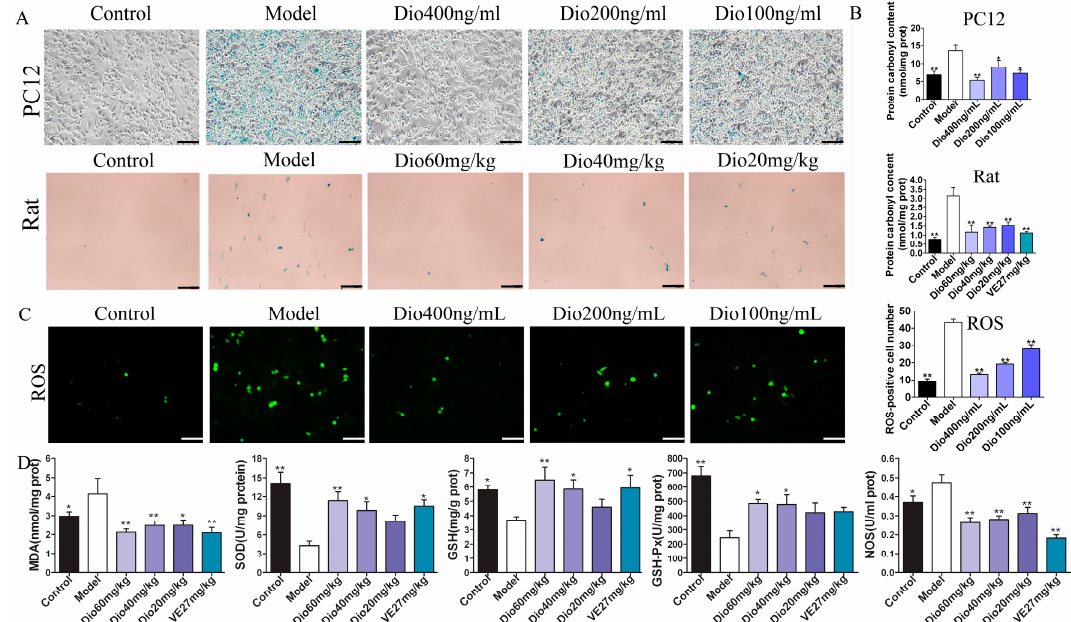
Figure 6. Effects of dioscin on oxidative damage and cell senescence in vitro and in vivo. ( A ) Dioscin reduces cell senescence in vitro (200× magnification, Scale bar = 100 μ m) and in vivo (400× magnification; Scale bar = 50 μ m). ( B ) Dioscin reduces protein carbonyl content in vitro and in vivo. ( C ) Effects of dioscin on intracellular ROS level in PC12 cells treated by H 2 O 2 (200× magnification; Scale bar = 100 μ m). ( D ) Effects of dioscin on the levels of malondialdehyde (MDA), superoxide dismutase (SOD), glutathione (GSH), glutathione peroxidase (GSH-Px) and nitric oxide synthase (NOS) in brain tissue of aging rats. Data are presented as the mean ± SD (n = 10). * p < 0.05 and ** p < 0.01 compared with model groups.